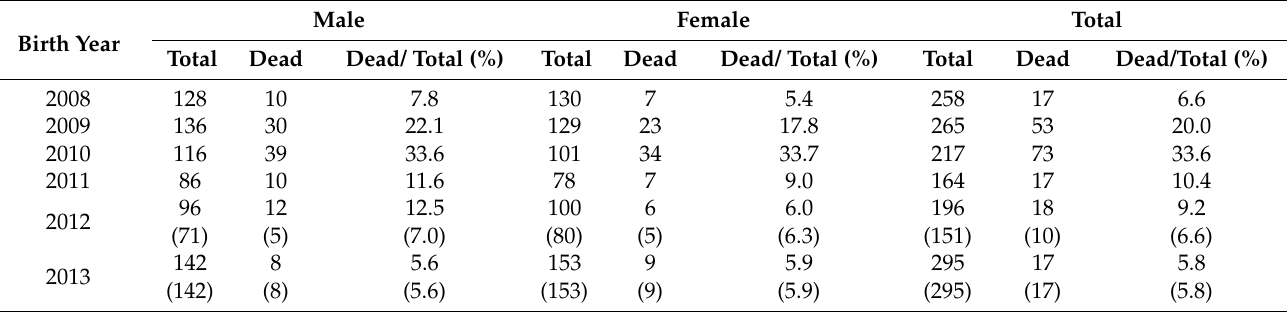
Figure 1. Representative symptoms of PCVAD observed in the pig population. Photographs ( a ) and ( b ) show littermates. Pigs indicated by red rectangles demonstrated typical growth retardation in comparison with other littermates. Table 1. Mortality of rearing pigs in the Duroc population.